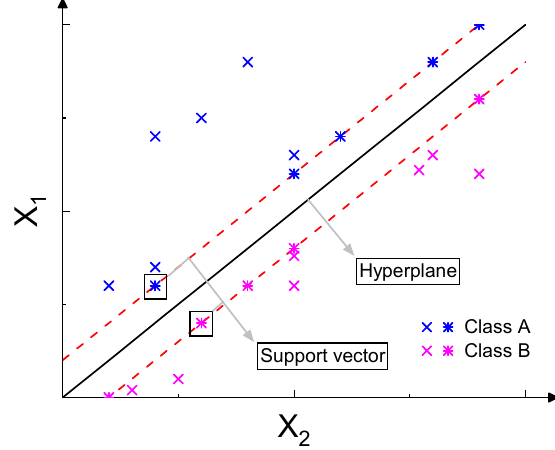
Figure 4. An illustration of support vector machine (SVM).